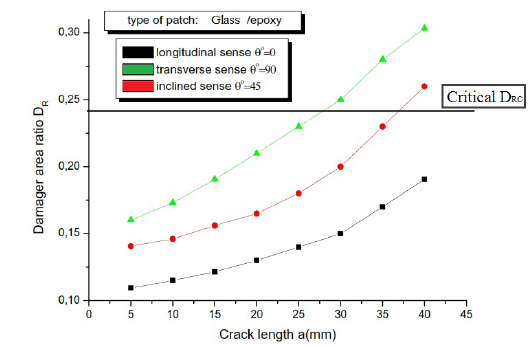
Figure 11. Variation of the damaged area ratio DR as a function of the fibers orientation (°) for a glass / epoxy patch.